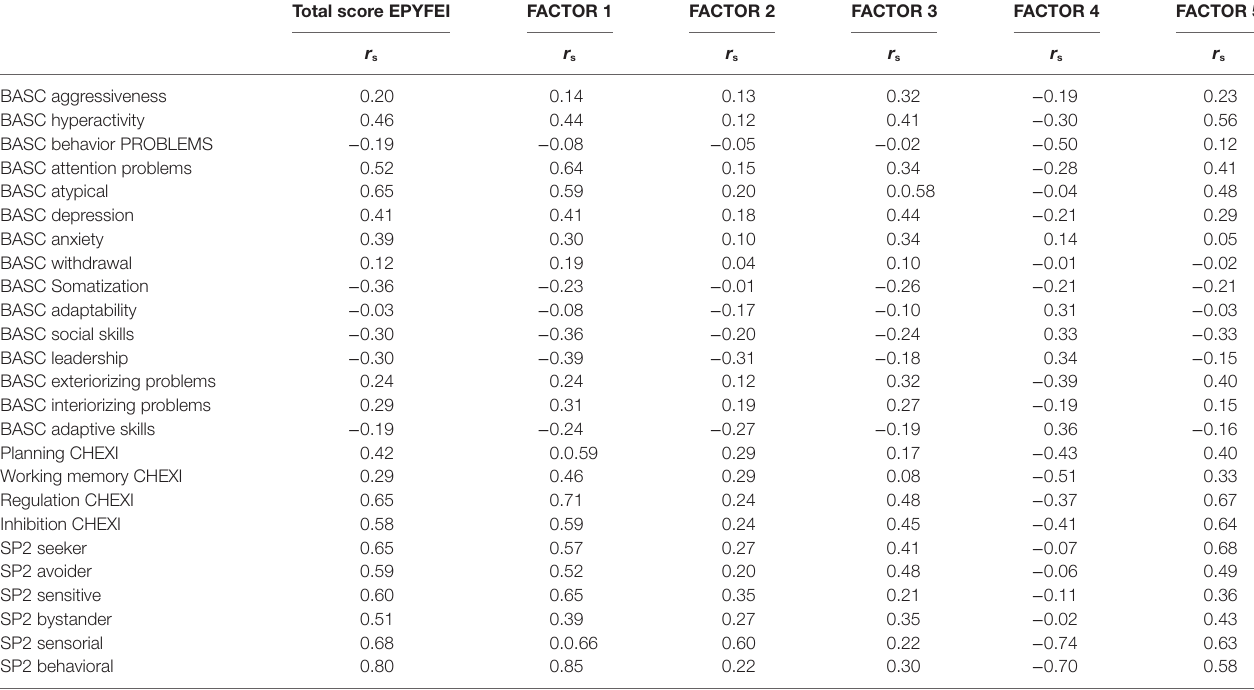
tAble 3 | Correlation between the EPYFEI and the BASC, the CHEXI, and the SP2 questionnaires.